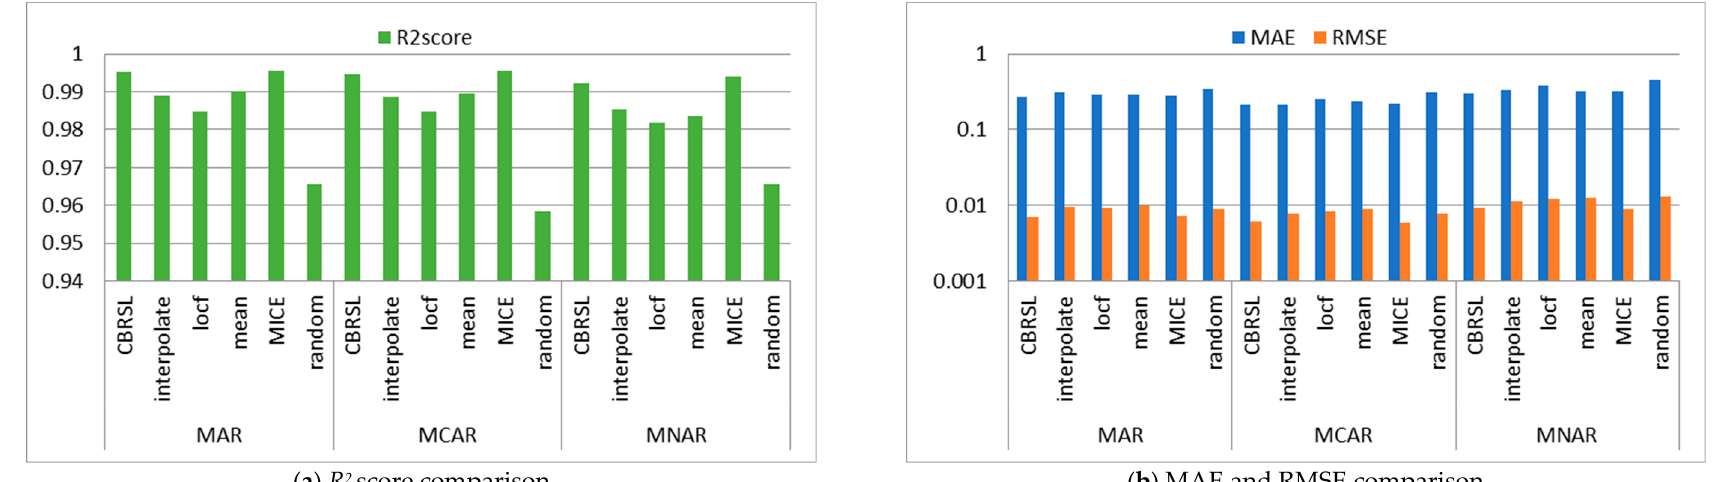
Figure 3. Comparison between the proposed algorithm, interpolate, locf, mean, MICE and random methods (Dermatology Dataset).